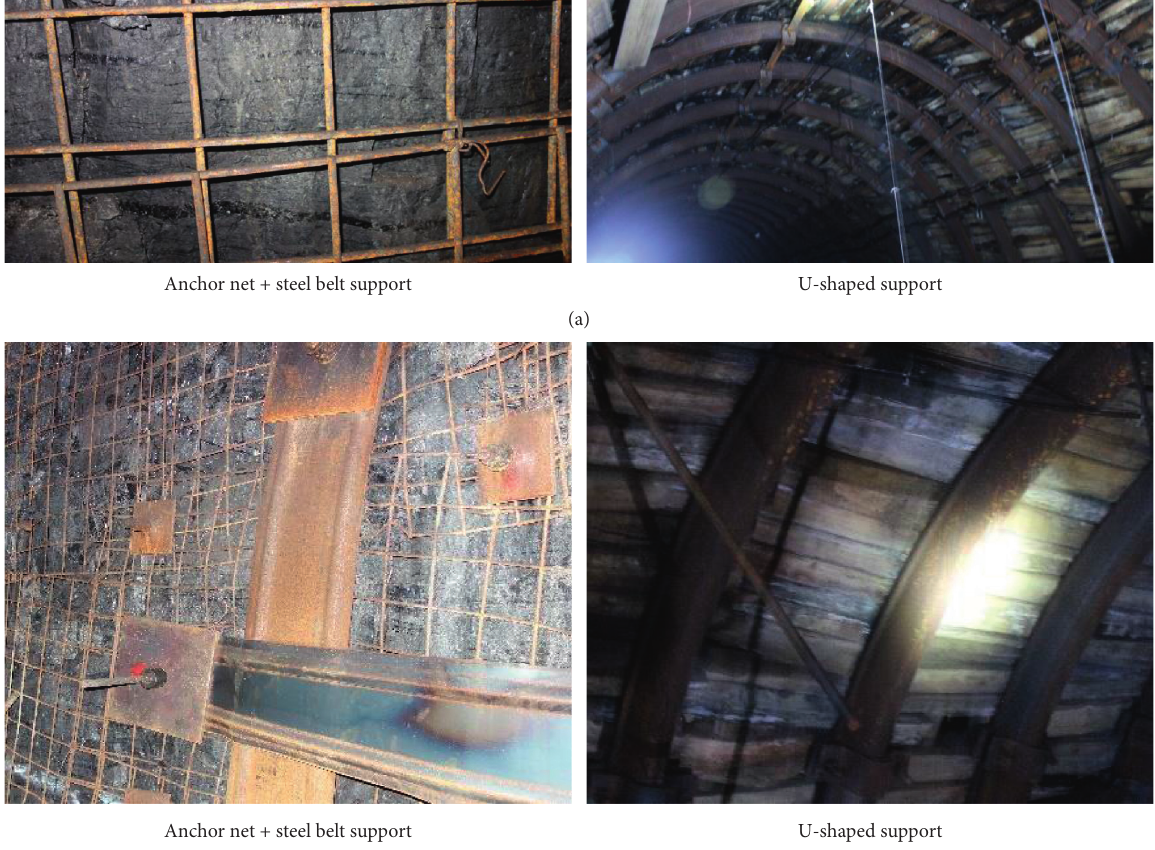
Figure 10: Coal wall failure in monitoring points. (a) The first group. (b) The second group.